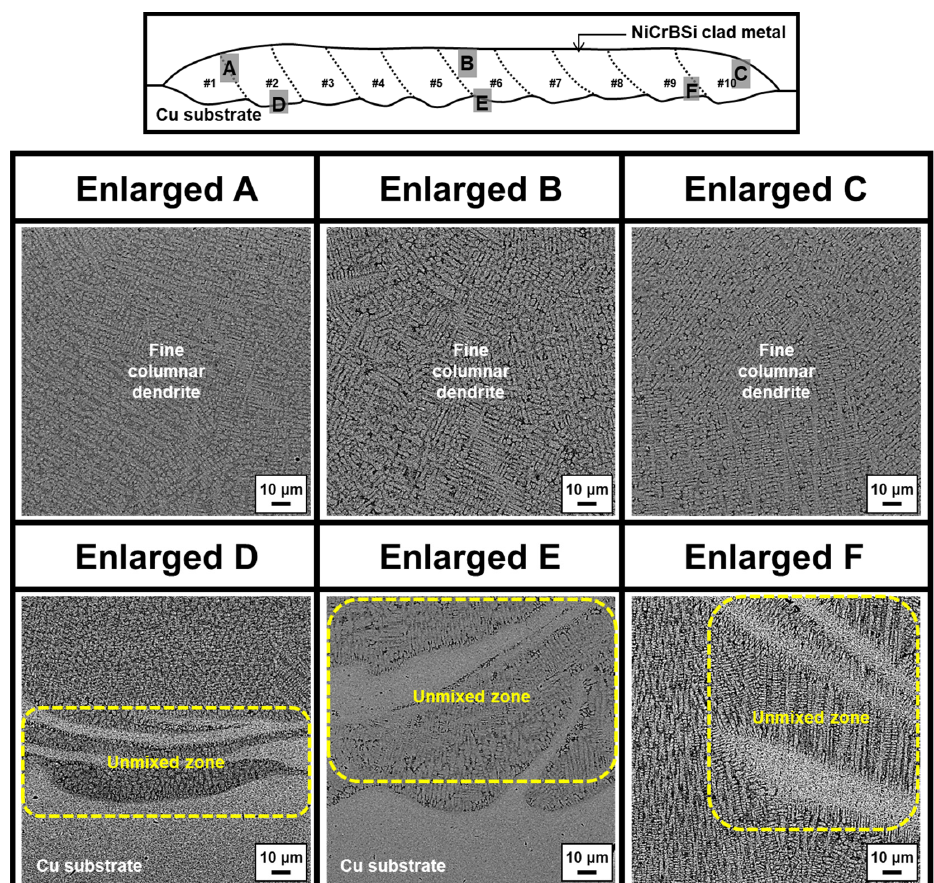
Figure 3. SEM microstructures of dissimilar laser clads (backscattered electron images).